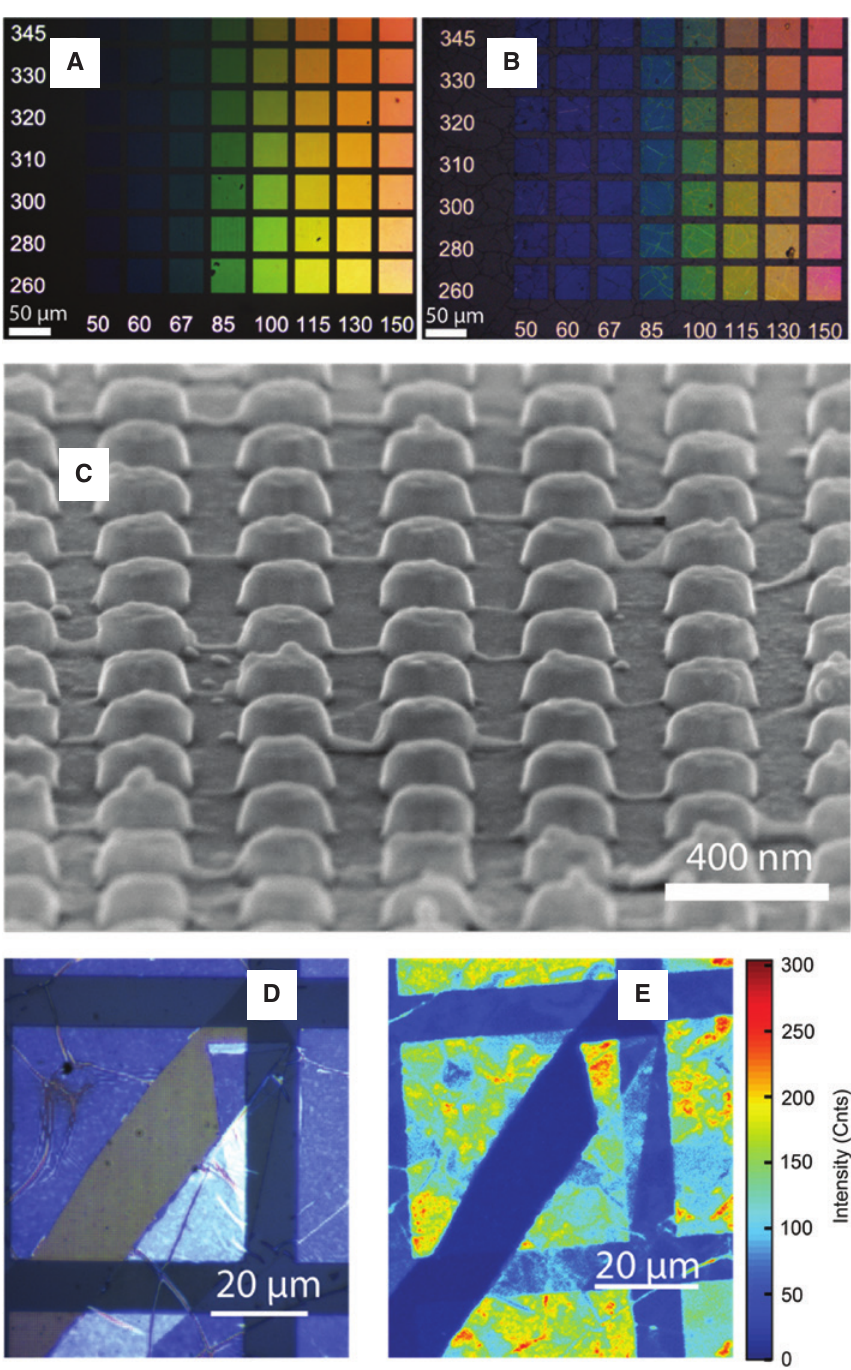
Figure 2: Ag nanopillar arrays capped with transfered hBN. (A) The bright field optical microscopy image of various Ag pillar arrays on a glass substrate. The pitch increases vertically while the pillar diameters increase horizontally. The target sizes (in nm) are visible along the left and bottom sides of the patterned region. (B) Same as in (A) but after the transfer of a 20 nm-thick sheet of hBN. (C) The angled SEM image of the Ag pillar array covered with 20 nm hBN film. The hBN film takes the shape of the substrate without tearing. (D) The optical microscope image of partially torn hBN on the Ag pillar array having 150 nm diameter pillars and a 470 nm lattice period. (E) The confocal PL image of the same array as in